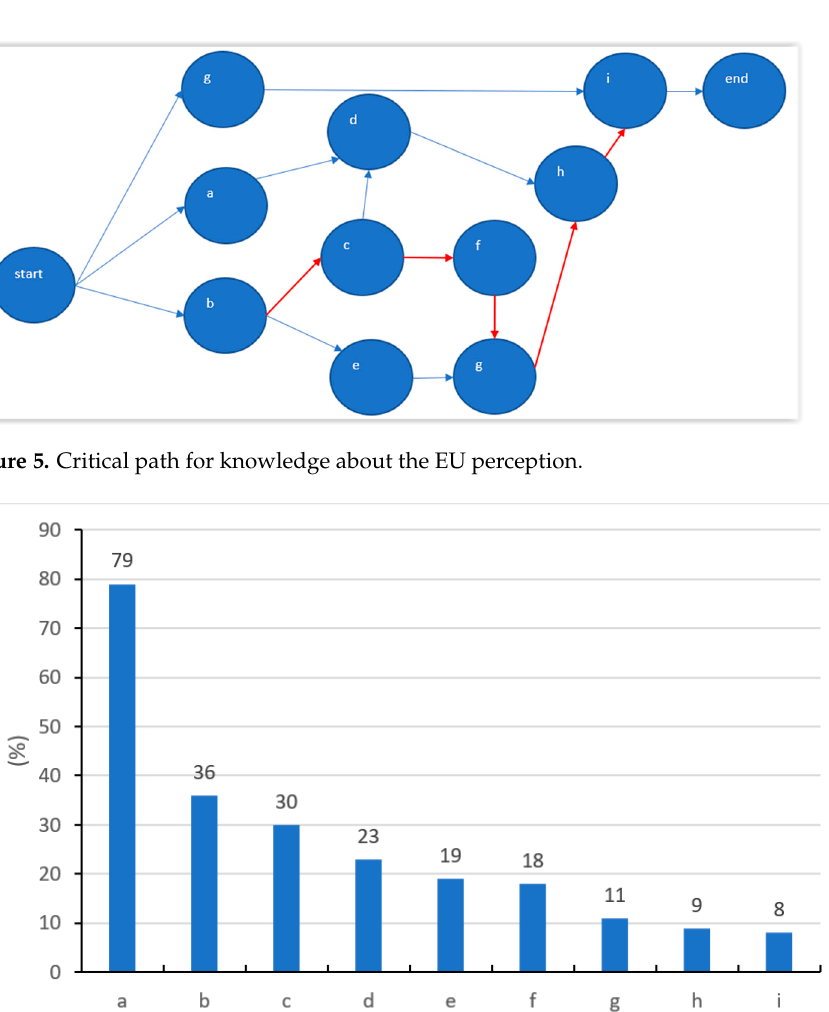
Figure 5. Critical path for knowledge about the EU perception.